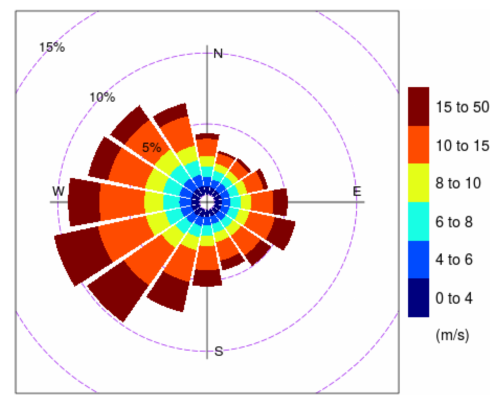
Figure A2. Wind direction histogram. Wind speed bins are indicated by different colors.